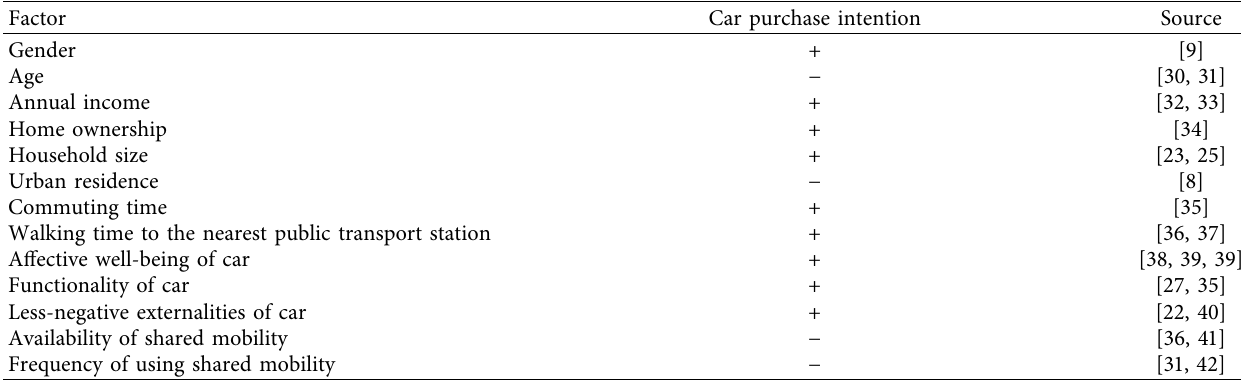
Table 1: Summary of influencing factors in the literature.